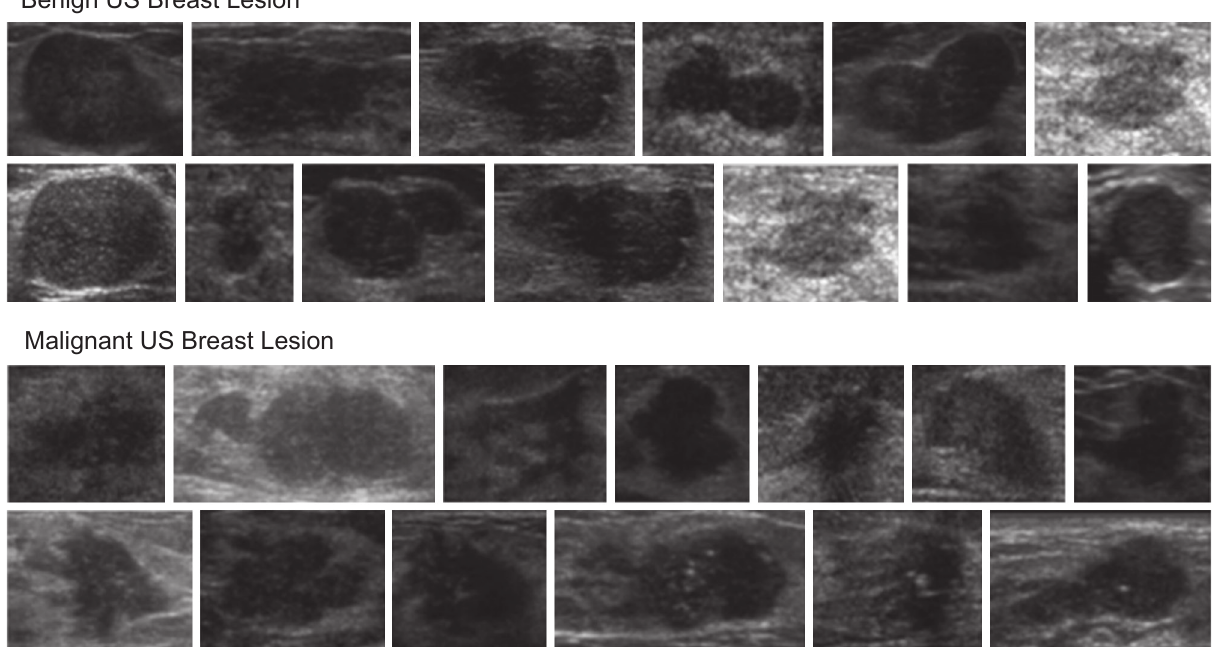
Figure 3 Stacked denoising autoencoder (SDAE) technology is used to encode US image of breast lesions in US images. (Reprinted with permission from [21])